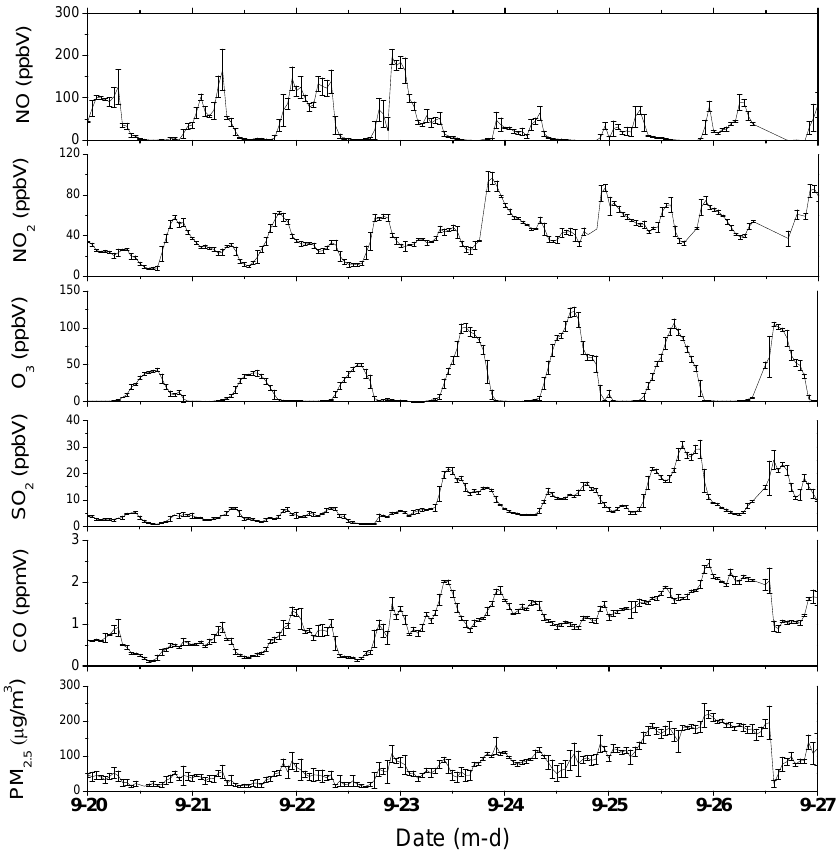
Fig. 1. Time series of observed NO, NO 2 , SO 2 , O 3 , CO, and PM 2 . 5 in Beijing from 20–27 September